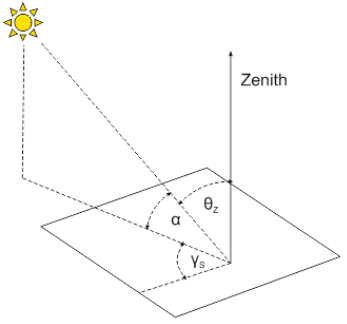
Figure 13. Scheme of solar radiation falling on a horizontal surface; α is the elevation angle of the sun, θ z is the solar zenith angle, and γ S is the azimuthal angle of the sun.